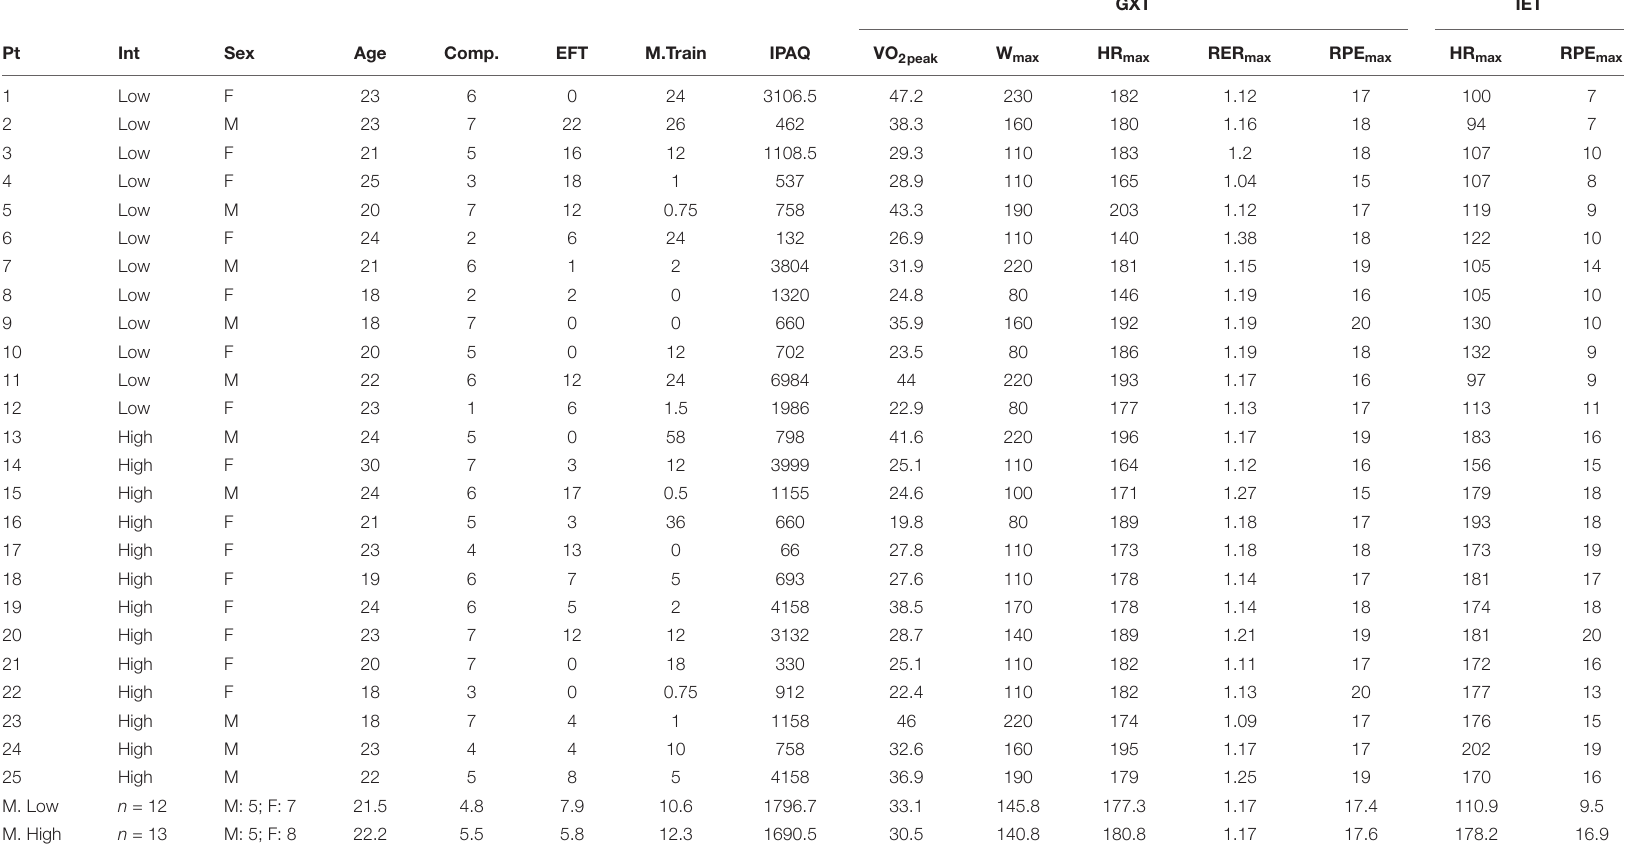
TABLE 1 | Descriptive data of